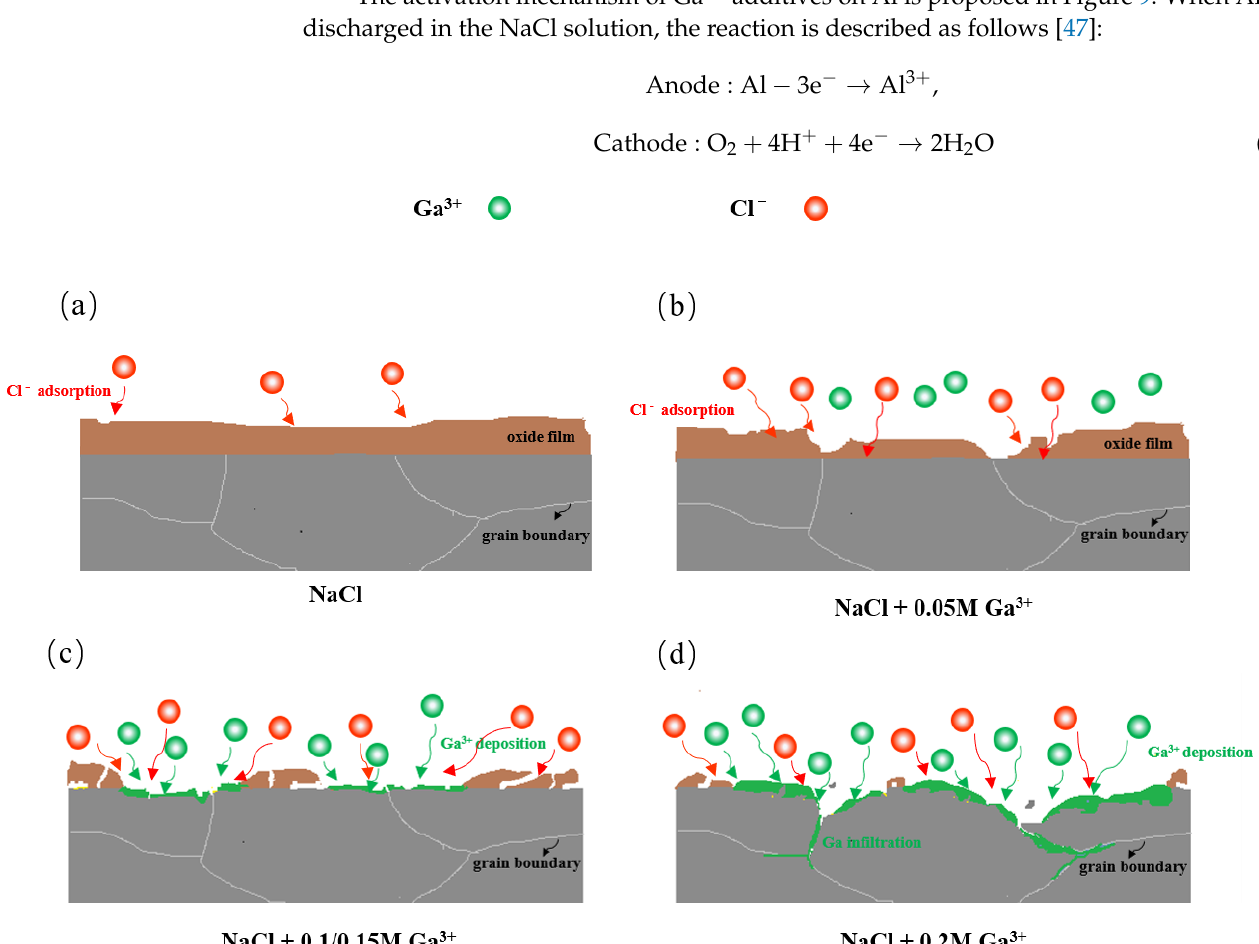
Figure 9. Activation mechanism of Al in the 2 M NaCl electrolyte ( a ) without and with different contents of GaCl 3 additives: ( b ) 0.05 M, ( c ) 0.1 and 0.15 M, ( d ) 0.2 M.